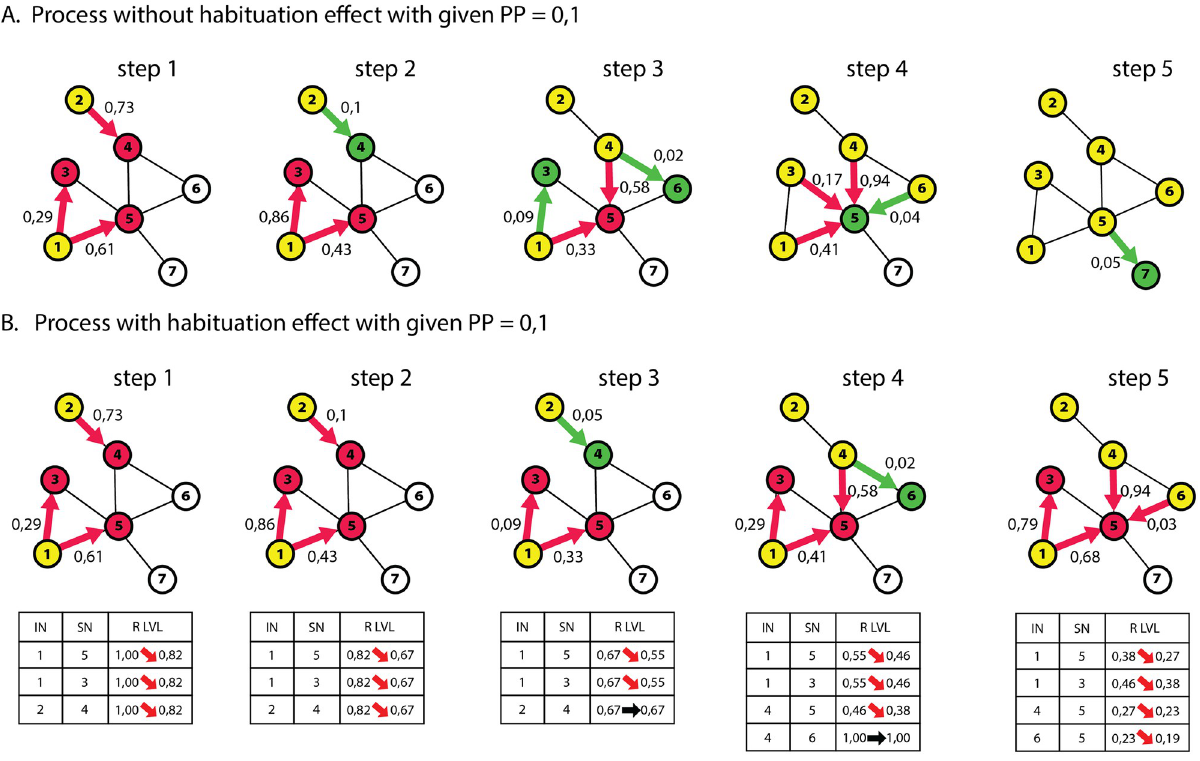
Fig 3. Toy example showing the steps of the simulation for processes with and without the habituation effect.